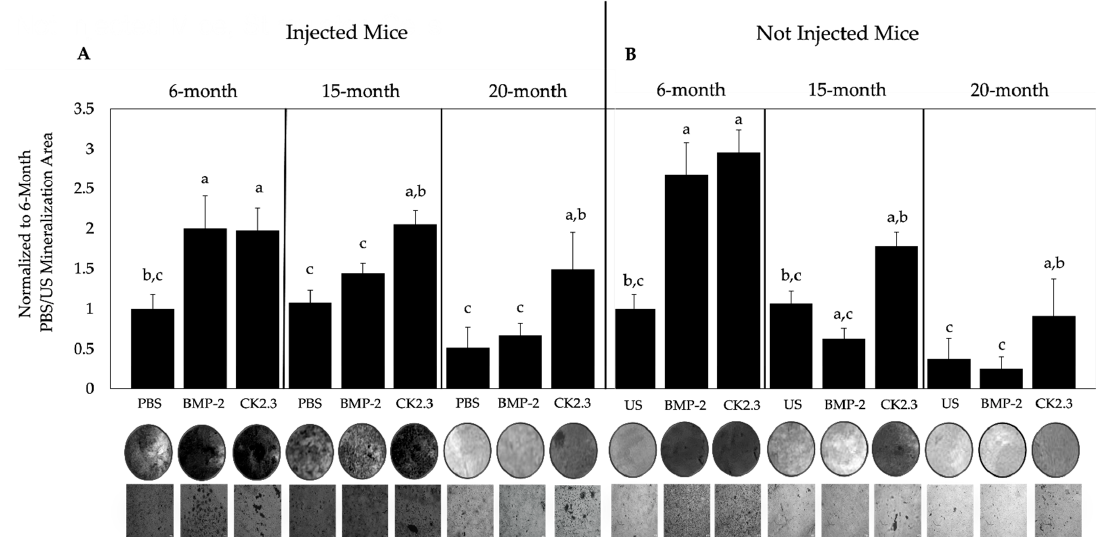
Figure 5. Mineralization deposition of BMSCs isolated from injected and not injected 6-, 15-, and 20-month-old B6 mice. ( A ) Mice were injected with PBS, 5 µ g/kg BMP-2, or 2.4 µ g/kg CK2.3 for five days. ( B ) Cells were isolated from US mice and stimulated with 40 nM BMP-2, 100 nM CK2.3, or left US. All BMSCs were assayed using the von Kossa method and mineralization deposits were analyzed using ImageJ. Representative images of dishes and magnified deposits are displayed underneath the bars. BMP-2 and CK2.3 had significantly higher mineralization area compared to PBS and US in 6-month-old mice and only CK2.3 significantly increased mineralization compared to PBS and US in 15- and 20-month-old mice. Experiments were repeated in triplicates with five mice per group. Statistical analyses were conducted using the students’ t -test and the Tukey–Kramer HSD test. Error bars represent standard error of the mean, and “a, b, c” signifies statistical significance and represents bars 1, 2, and 3 of each group. Scale bars are set to 10 µ m. Int. J. Mol. Sci. 2022 , 23 , x FOR PEER REVIEW